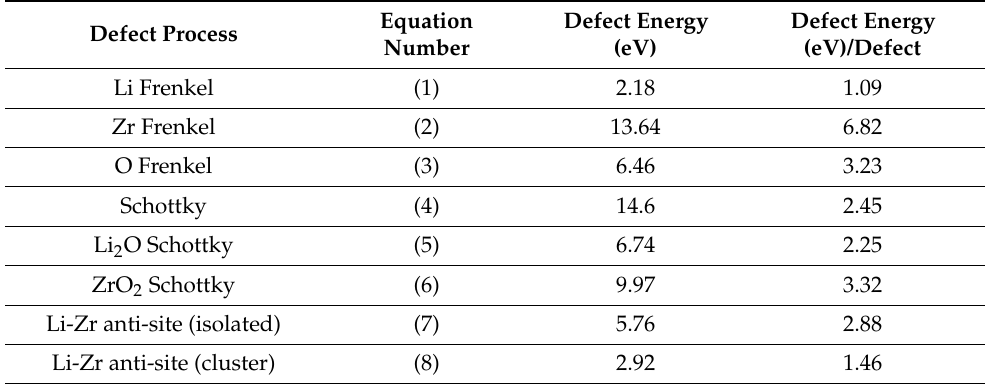
Table 3. Defect formation energies of intrinsic defect process calculated in monoclinic LZO.